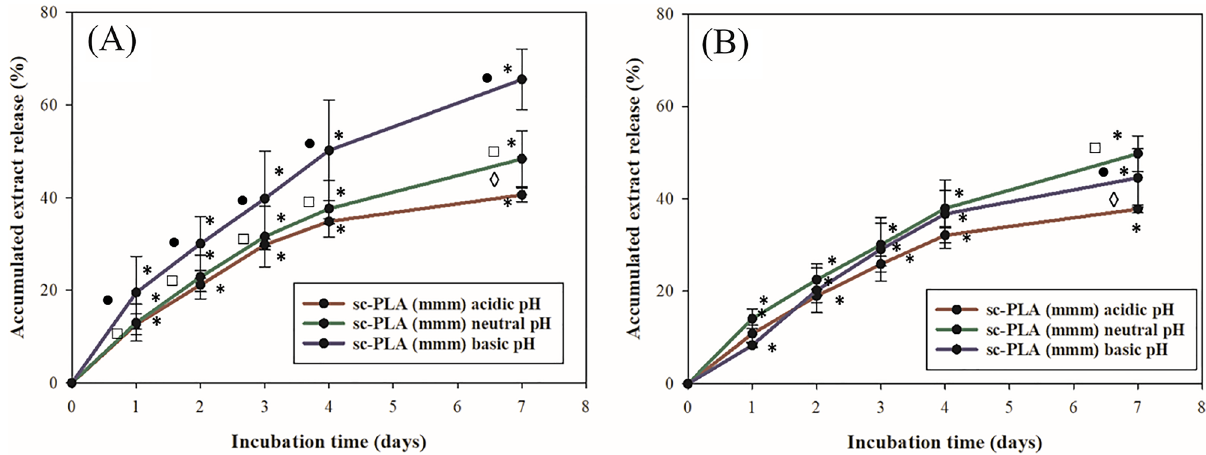
Figure 4. In vitro release profiles of extracts from stereocomplexed microspheres (sc-PLA), formed by multiple H-bonds between poly(l-lactide) (PLLA) and poly(d-lactide) (PDLA) chains. The sc-PLA with medium molecular mass (mmm) loaded with S. cadmica aerial part extract—SCAPE (A) or with S. cadmica root extract—SCRE (B) . Statistical significance for p < 0.05 in the non-parametric Kruskal–Wallis test, for extract release *according to the time: 1 vs . 2; 2 vs . 3; 3 vs . 4; 4 vs . 5; 5 vs . 6; 6 vs . 7 (days for each pH value separately); filled circle—basic pH vs . neutral pH according to the same time point; open square—basic pH vs . acidic pH according to the same time point; open diamond—neural pH vs . acidic pH according to the same time